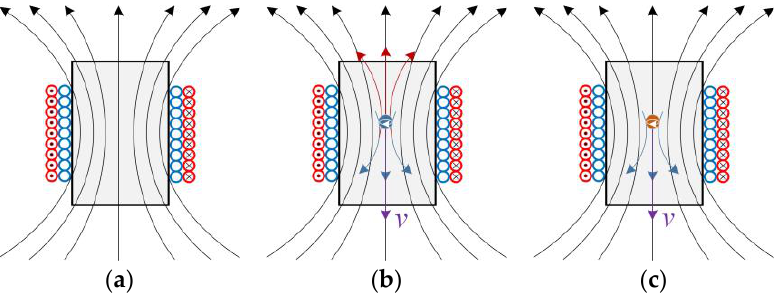
Figure 1. Distribution of magnetic field in the designed sensor: ( a ) no metal debris passes through; ( b ) when ferrous metal debris enters the sensor; ( c ) when non-ferrous metal debris enters the sensor.